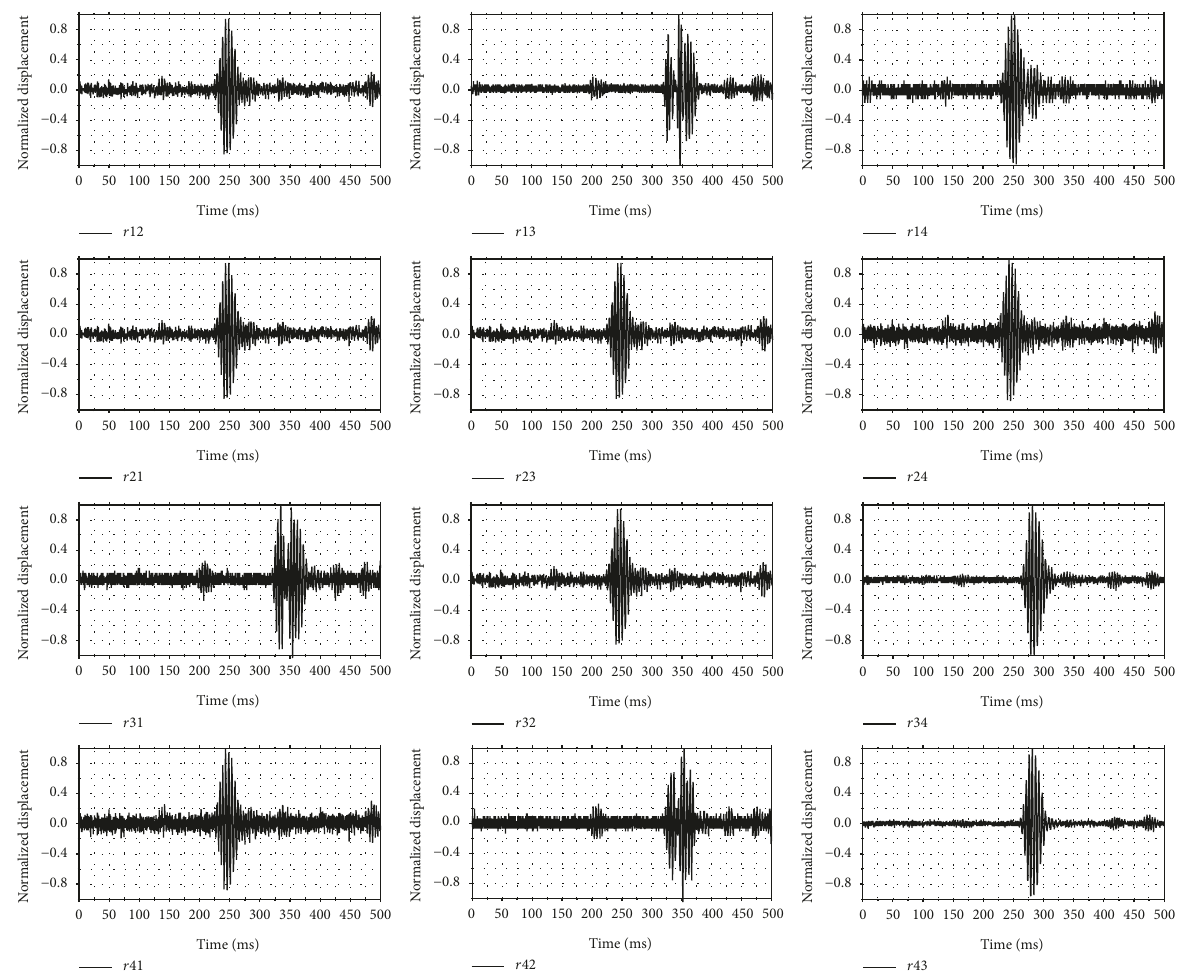
Figure 13: Residual signals of different transmitter-receiver pair